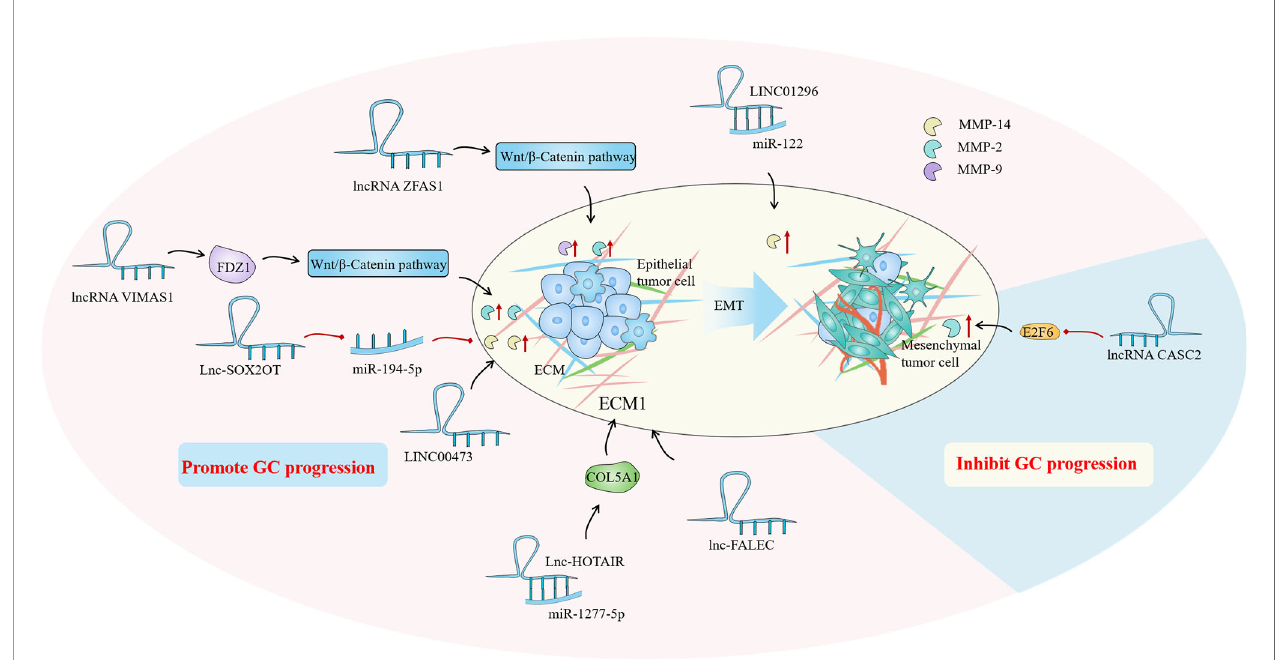
FIGURE 3 | In the gastric cancer (GC) immune microenvironment (TIME), lncRNAs mainly regulate by regulating matrix metalloproteinases (MMPs) and epithelial- mesenchymal transition (EMT) to achieve the regulation of extracellular matrix (ECM), and then play a role in promoting or inhibiting GC